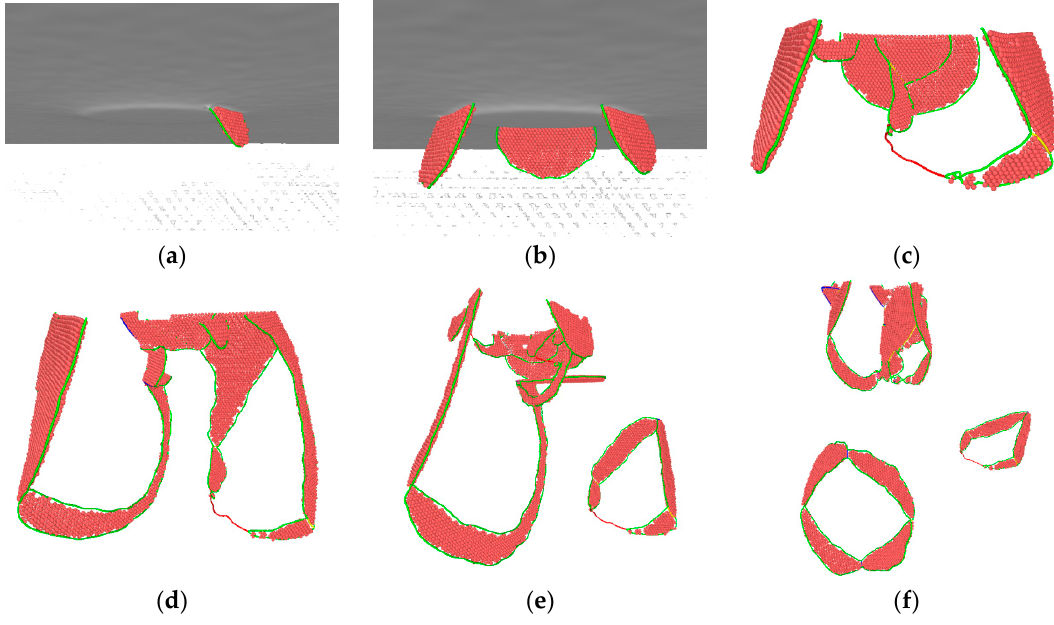
Figure 16. Defect nucleation and evolution of Ni thin film indented by a cylindrical indenter at different indenter tip displacements of ( a ) d ≈ 0.70 nm; ( b ) d ≈ 0.86 nm; ( c ) d ≈ 0.96 nm; ( d ) d ≈ 1.02 nm; ( e ) d ≈ 1.05 nm; ( f ) d ≈ 1.12 nm (after Voyiadjis and Yaghoobi